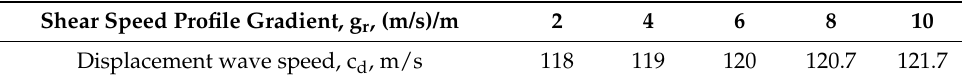
Figure 11. By increasing the mesh density and frequency, the wavelength can be better measured. Five whole waves were selected, and the corresponding number of elements was found to be 119. This gave a wavelength of 1.4875 m and a wave speed of 119 m/s. The gradient in this model was 4 (m/s)/m. FE models in a sequence were run, each with different values of the gradient. The results are shown in Table 1. They were of limited precision, estimated at ± 0.5 m/s, but showed a clear trend. Table 1. The variation of wave speed with depth